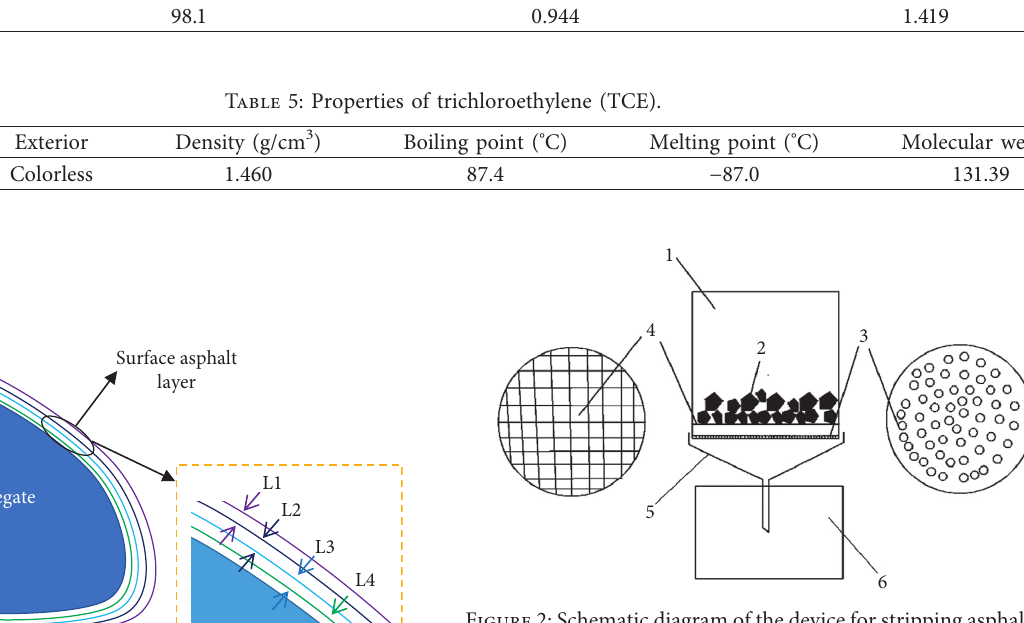
Figure 2: Schematic diagram of the device for stripping asphalt. (1) Container; (2) RAP; (3) chassis; (4) net-shaped support; (5) re- ceiving funnel; (6) solution collecting